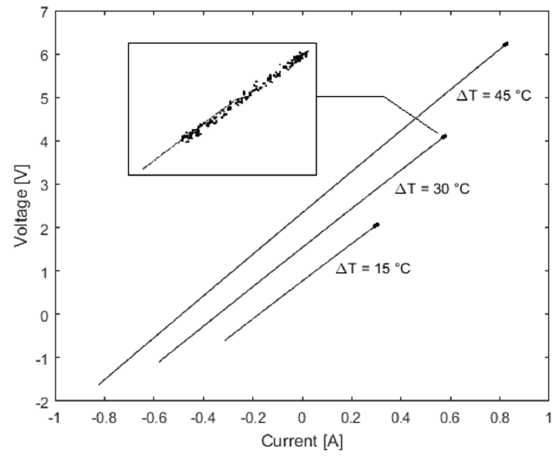
Figure 2.  I V plot for three different bias point of the CS (solid) vs. SS one (bold). Figure 2. I − V plot for three different bias point of the CS (solid) vs. SS one